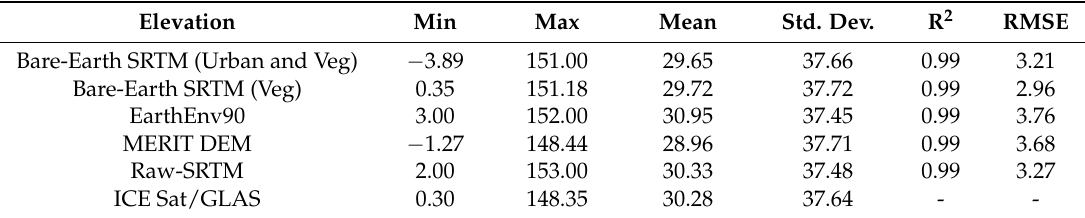
Table 5. SRTM and Modifications comparison with ICE Sat/GLAS altimetry elevation. Elevation Min Max Mean Std. Dev. R 2 RMSE Bare-Earth SRTM (Urban and Veg) − 3.89 151.00 29.65 37.66 0.99 3.21 Bare-Earth SRTM (Veg) 0.35 151.18 29.72 37.72 0.99 2.96 EarthEnv90 3.00 152.00 30.95 MERIT DEM − 1.27 Raw-SRTM 2.00 153.00 ICE Sat/GLAS 0.30 148.35 30.28 37.64 -